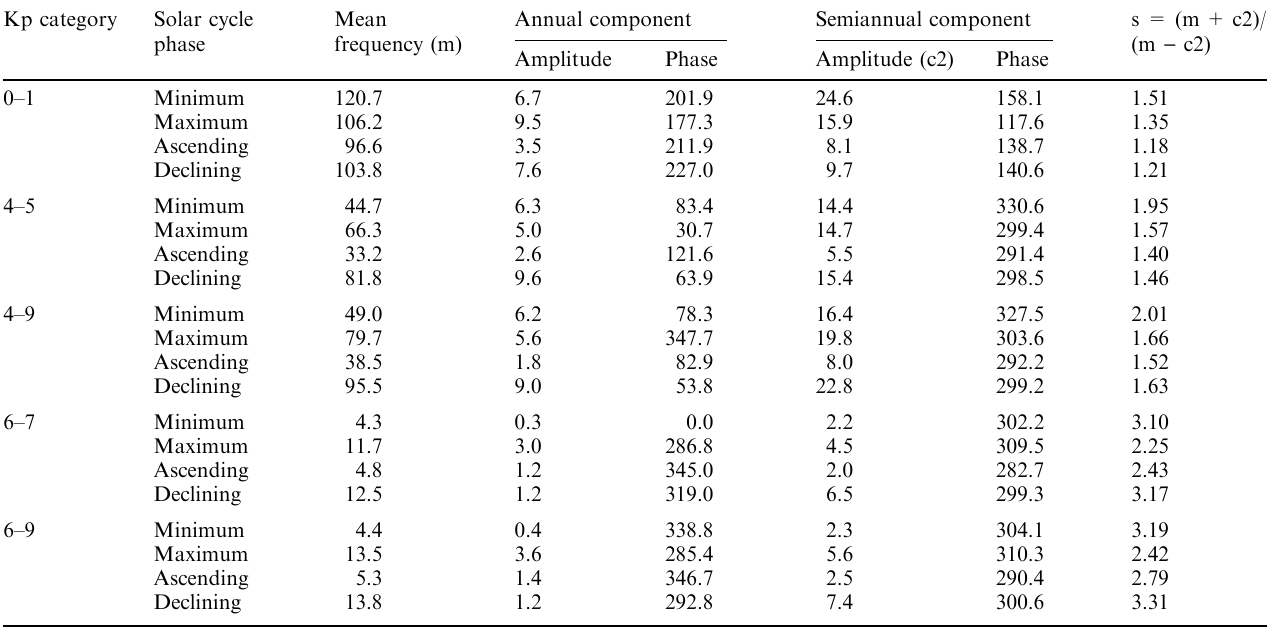
Table 7. Amplitudes and phases derived from harmonic analysis of the monthly occurrence frequencies of Kp in di(cid:128)erent phases of the solar cycle and the ratio of the frequencies at the maximum and minimum epochs Kp